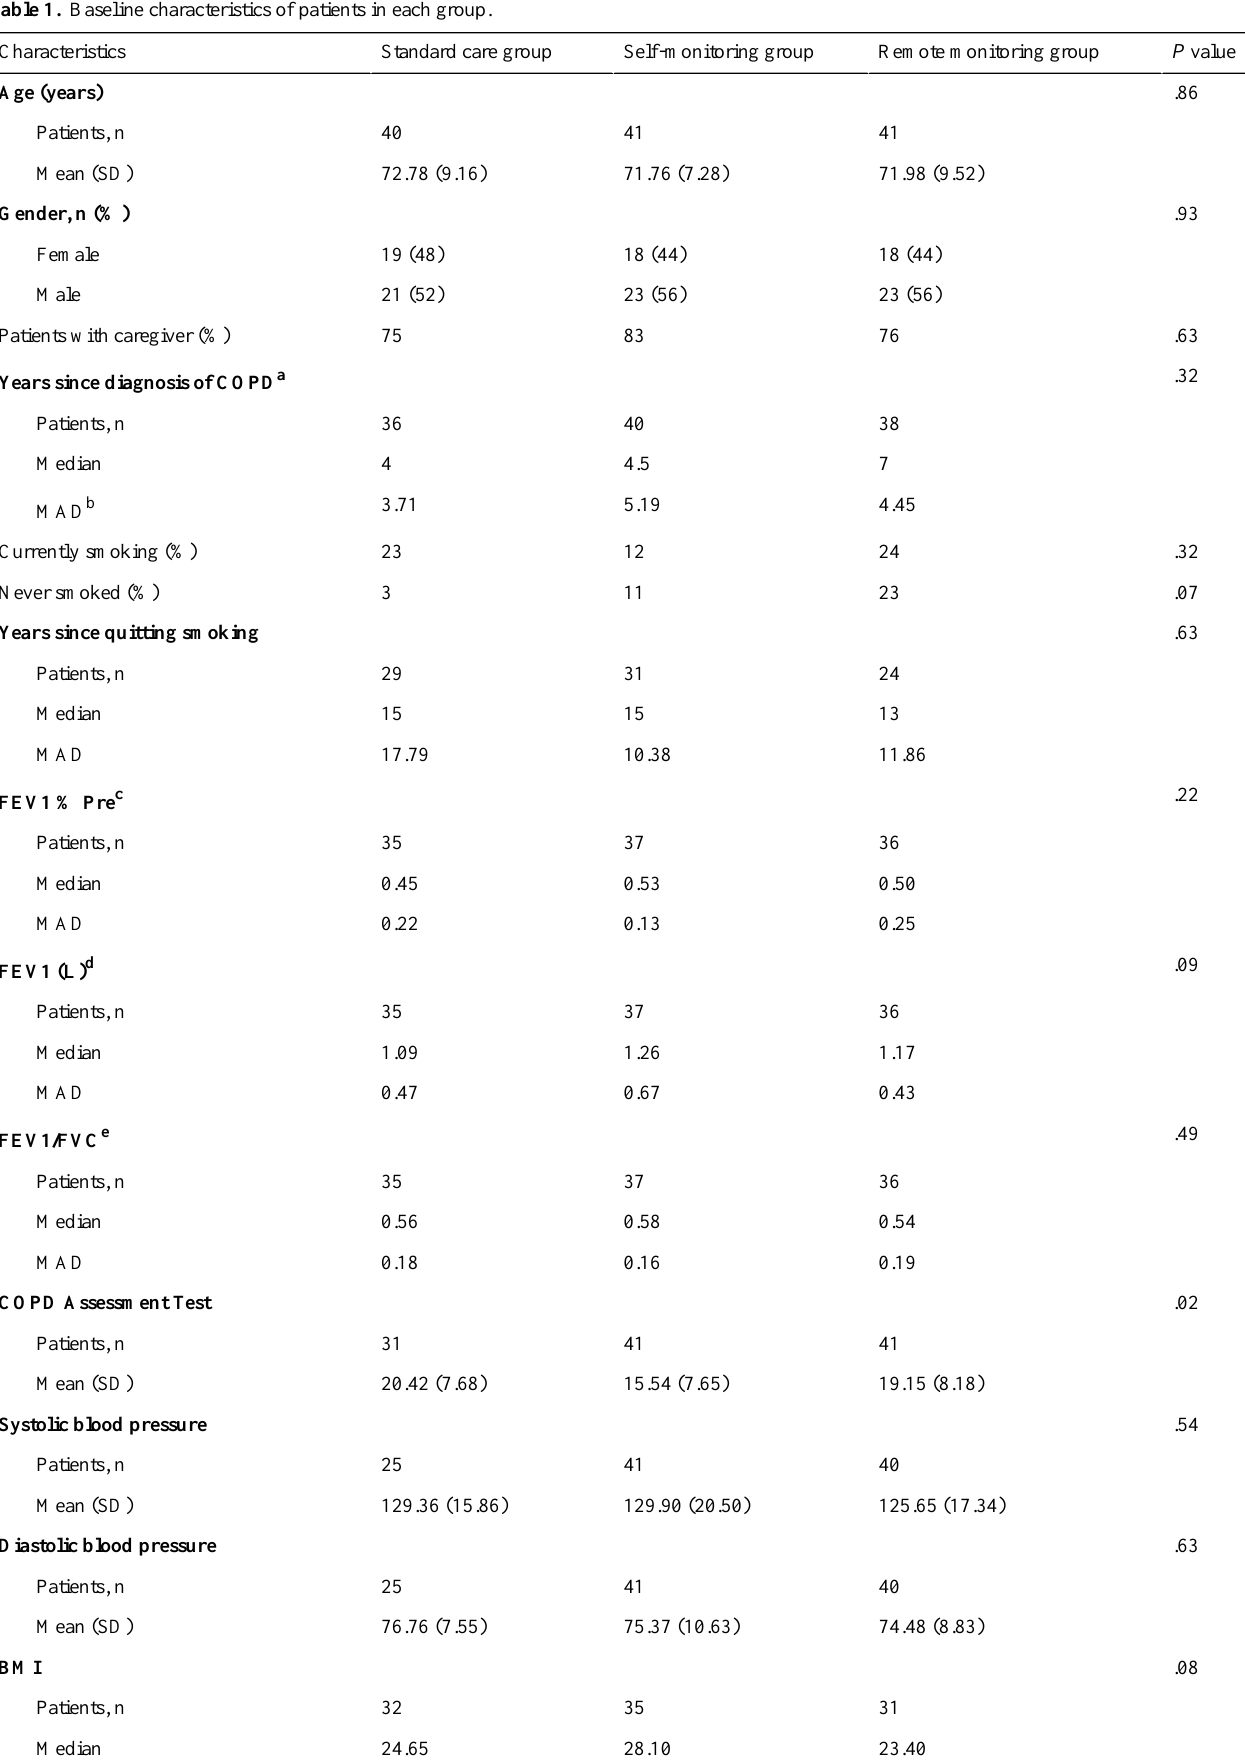
Table 1. Baseline characteristics of patients in each